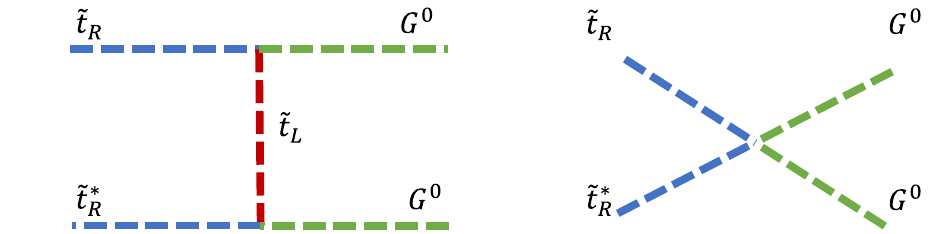
Fig. 1 Leading-order Goldstone-boson contributions to ˜ t R ˜ t ∗ R